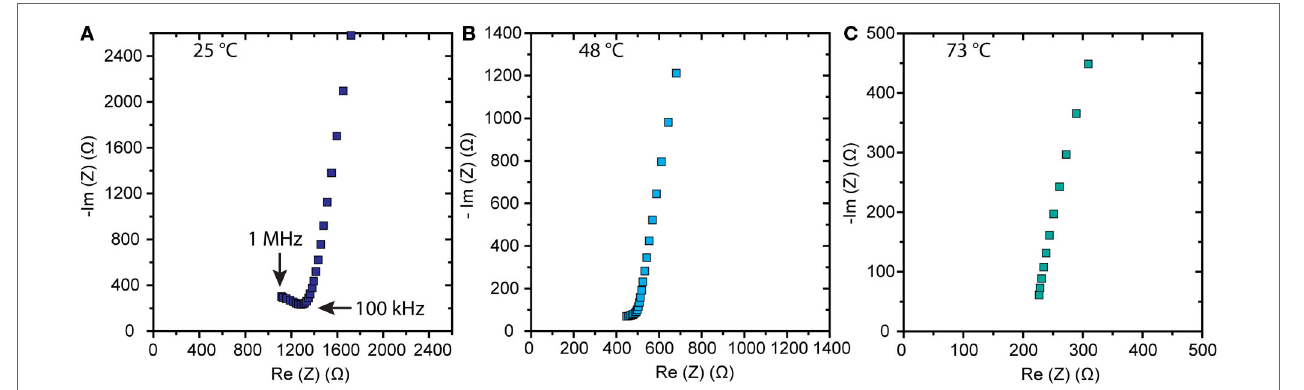
FigUre 2 | nyquist plots of impedance data obtained on an au/llZO/au cell at (a) 25, (B) 48, and (c) 73°c